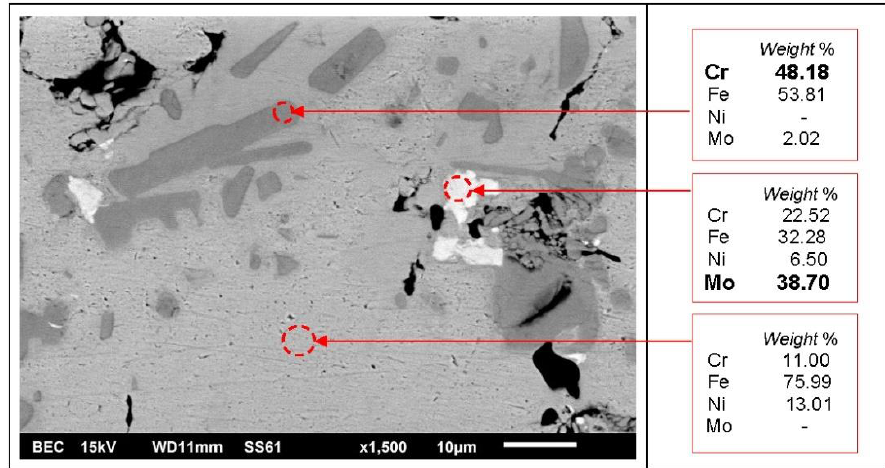
Fig. 8. Chemical analysis verified using punctual EDS-BEC technique in D15/1100